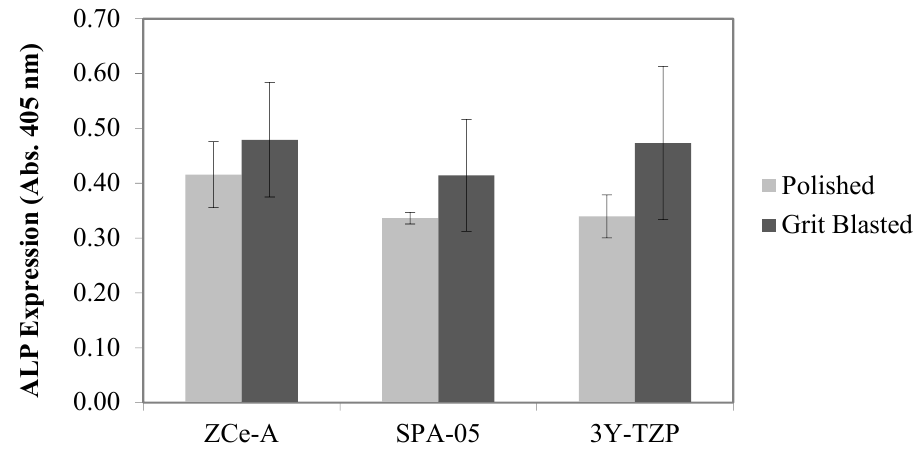
Figure 2. ALP expression (absorbance at 405 nm) achieved on polished and grit-blasted discs after incubation of SAOS-2 for seven days. The error bars represent standard deviation values.